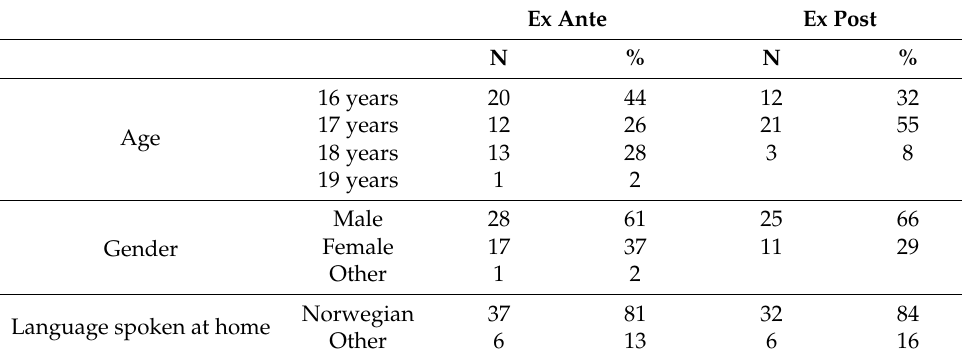
Table 3. Summary of students’